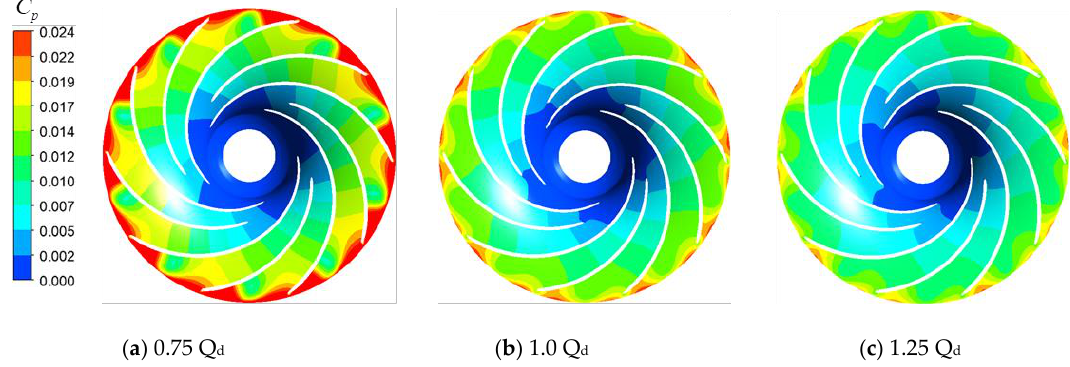
Figure 8. Pressure fluctuation distributions at the mid-span of the runner.